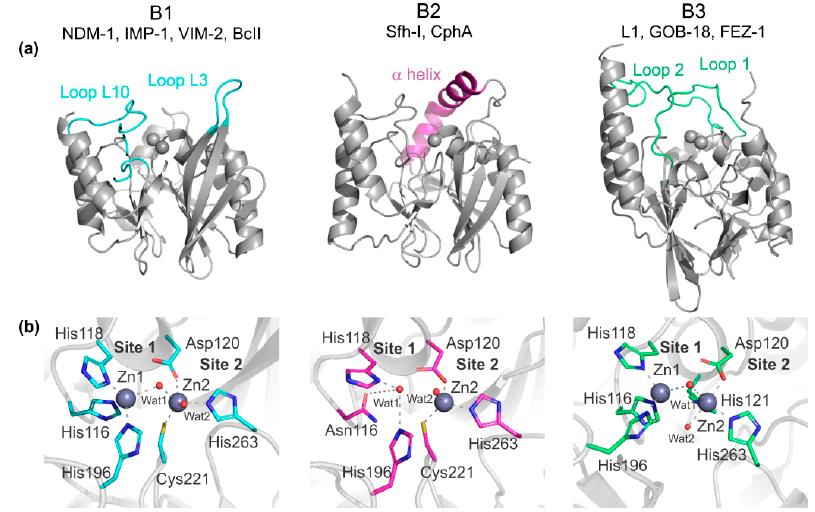
Figure 2. Representative structures of the three metallo- β -lactamases (MBLs) subclasses: B1 NDM-1 (PDB 3spu), B2 Sfh-I (PDB 3sd9), and B3 L1 (PDB 1sml). ( a ) Overall protein structures. Loops and helices involved in substrate interactions are shown in color. ( b ) Active sites. Zn(II) ions are shown as grey spheres and water / OH molecules as red spheres. Zn(II) interactions are shown as dashed lines and metal ligands are shown in color. Residues are numbered according to the standard MBL numbering scheme. For the B2 enzyme Sfh-I, the active mono-Zn(II) form is shown.